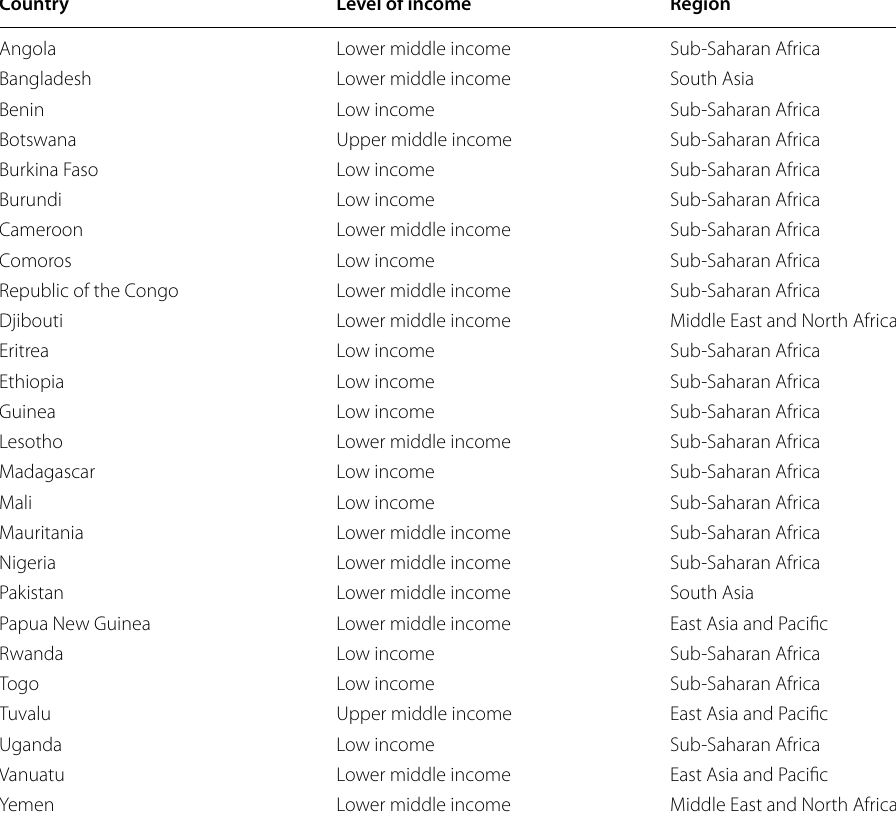
Table 3 Countries in the first quartile of the distribution of primary school gross graduation rates Country Level of